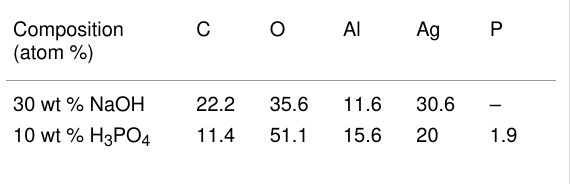
Table 2: Surface composition of nanoporous silver thin films with 30 atom % of initial Ag content and dealloyed for 60 min in different de- alloying media evaluated by